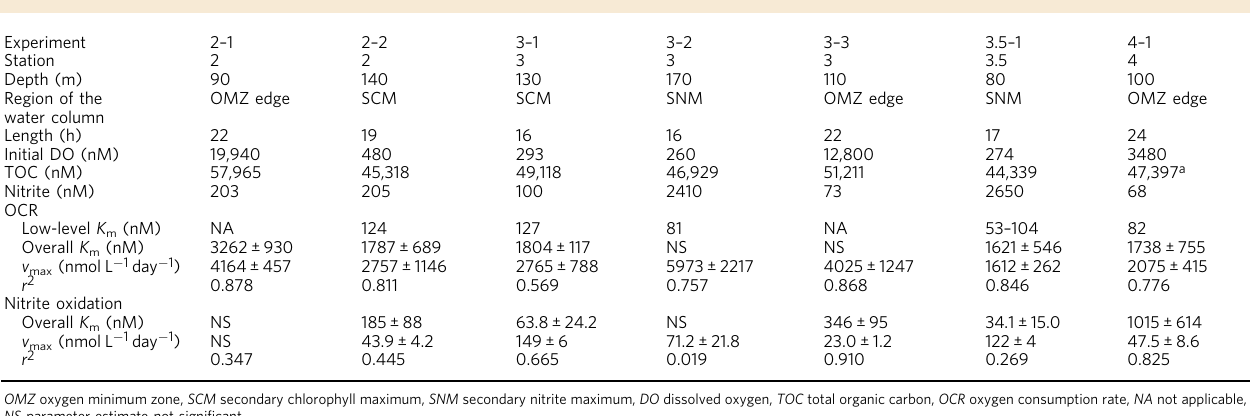
Table 1 Details of oxygen manipulation experiments, including station, sampling depth, region of the water column (edge of the OMZ, SCM, or SNM), and experiment length; initial DO concentration measured using oxygen sensor spots (FireSting, Pyroscience) prior to experimental manipulation, TOC, and nitrite concentrations; and calculated parameters for OCRs (including both low-level and overall K m values) and nitrite oxidation rates ( K m values are for dissolved oxygen in all cases, with ±standard error shown).